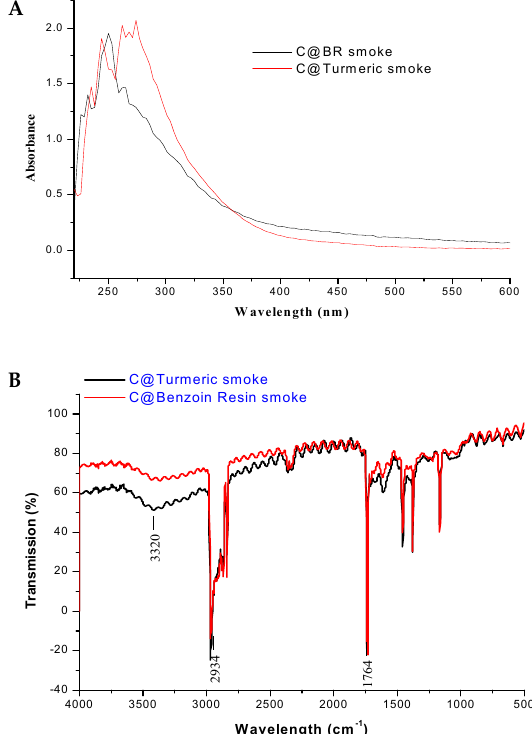
Figure 4. ( A ) UV–Vis curve of Tur and BR smoke. ( B ) FTIR of Tur and BR smoke.